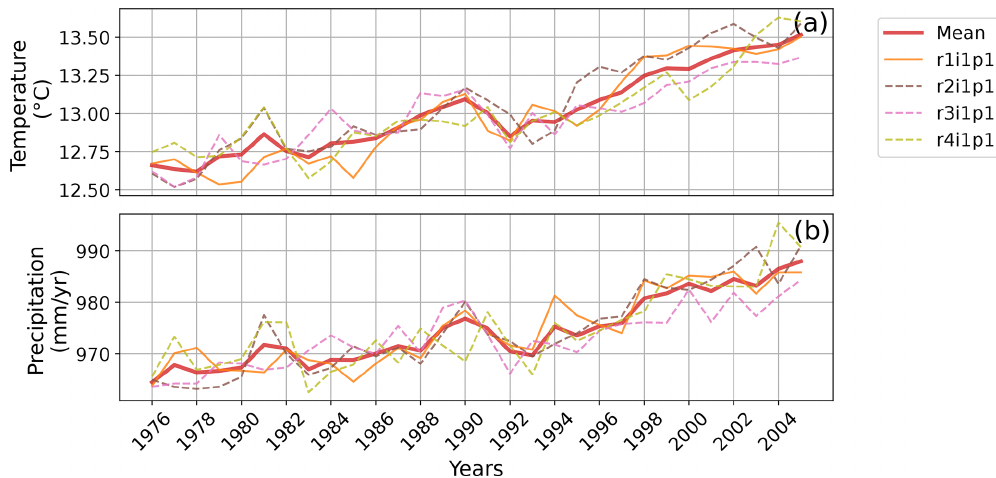
Figure A1. Temporal evolution of (a) temperature and (b) precipitation over the historical period (1976–2005) for the different ensemble members. The solid orange line depicts the historical simulation used in the study. The thick red line shows the ensemble mean of all simulations from r1i1p1 to r4i1p1.